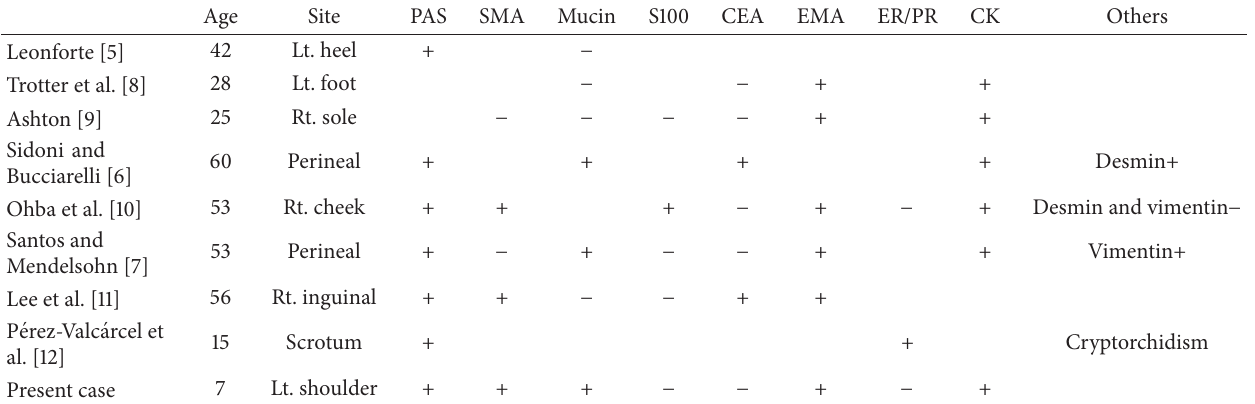
Table 1: Summary of the reported cutaneous ciliated cysts in male patients. The empty columns mean that the results are not